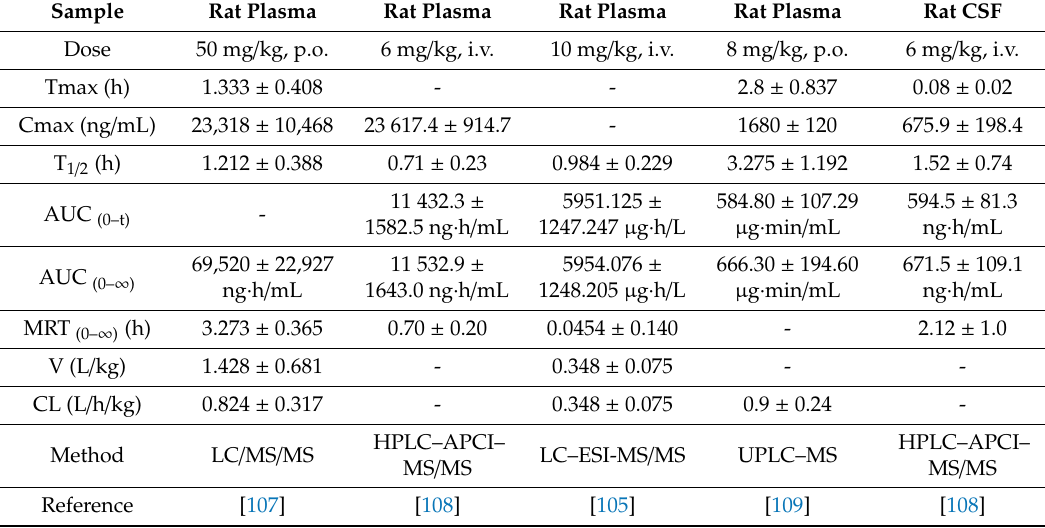
Table 7. Pharmacokinetics of catalpol in di ff erent